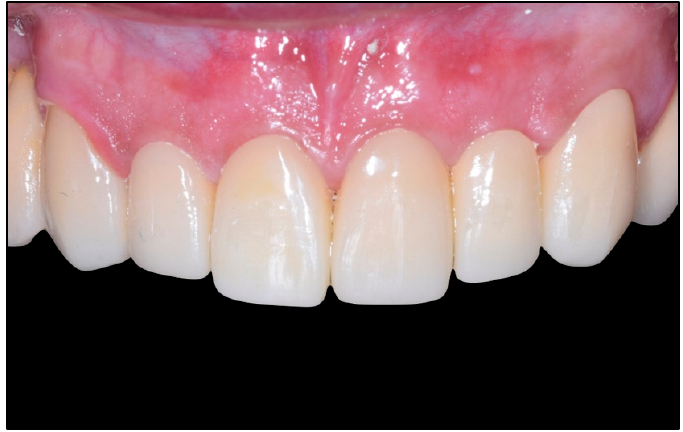
Figure 4. Final restorations. After periodontal maturation, the gingival architecture is restored, and full maturation of soft tissues can be observed.